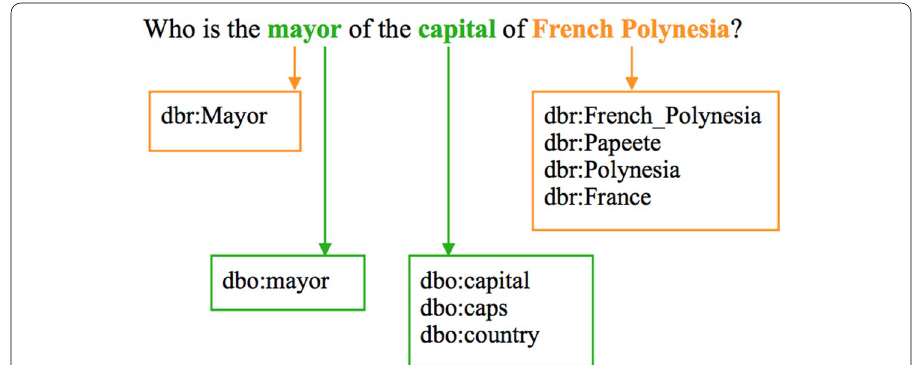
Fig. 3 The phrase mapping result for the example question: “Who is the mayor of the capital of French Polynesia?”. dbo DBpedia ontology, dbr DBpedia